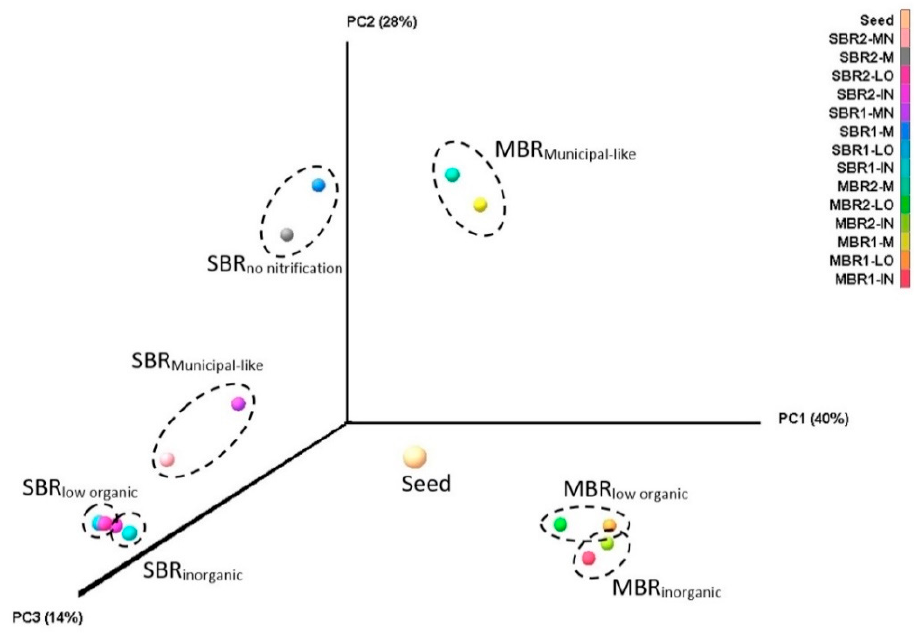
Figure 6. Bray–Curtis principle coordinates analyses (PCoA) plot showing the dynamics of microbial community of seed sludge under operation in pilot MBR and SBR reactors with different wastewater composition.